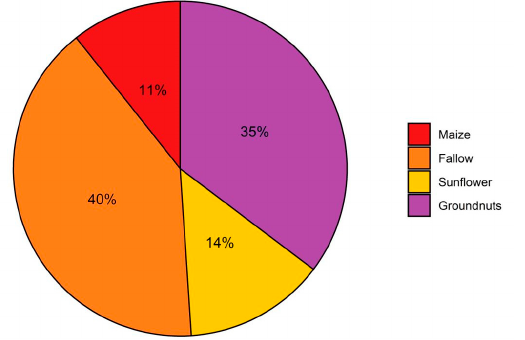
Figure 10. The relative sediment transport calculated from the average sediment flux. Note that flux data from wheat, sorghum, and soya beans are missing and that this data was excluded.